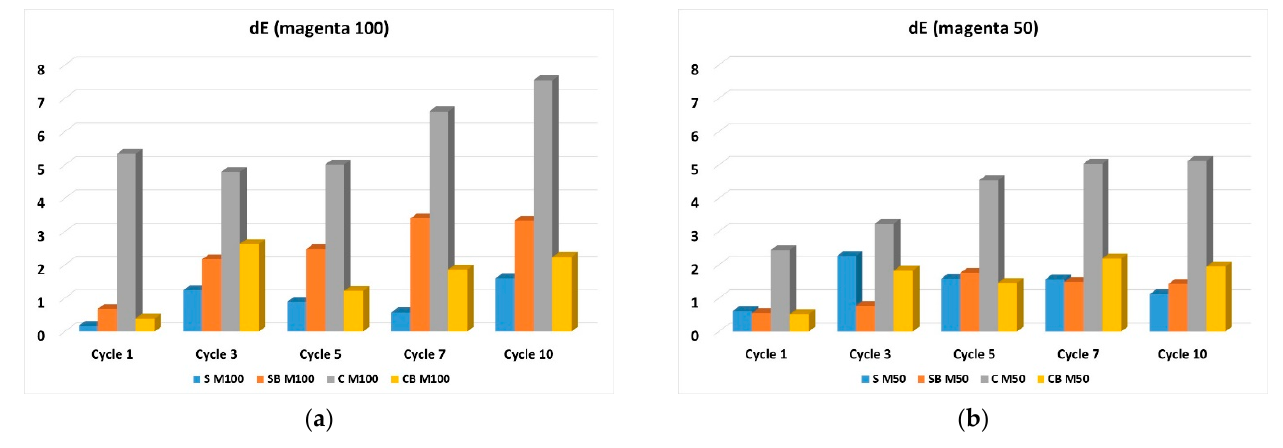
Figure 7. Total colour differences (dE) for washed samples compared with samples before washing, for magenta colour hue: ( a ) 100% ( b ) 50% of pigment.